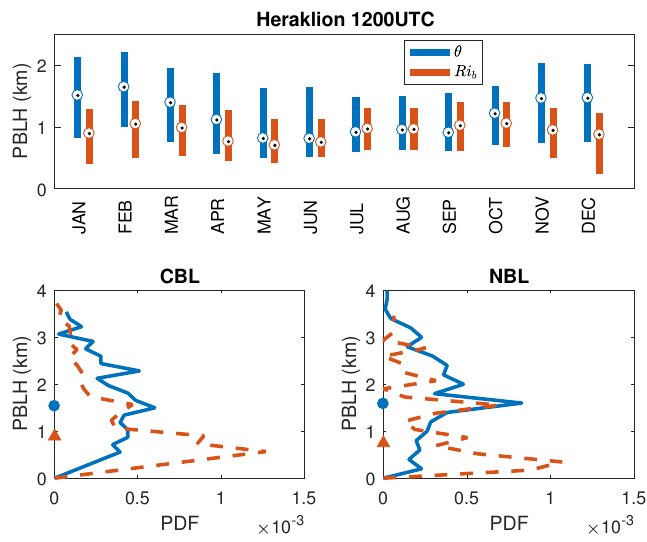
Figure 7. The same as in Figure 5 but for the 1200UTC soundings over